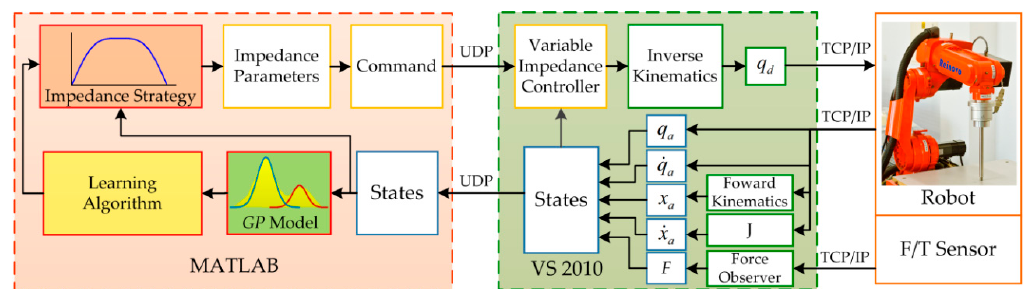
Figure 12. Hardware architecture of the system. Sensors 2018 , 18 , x FOR PEER REVIEW